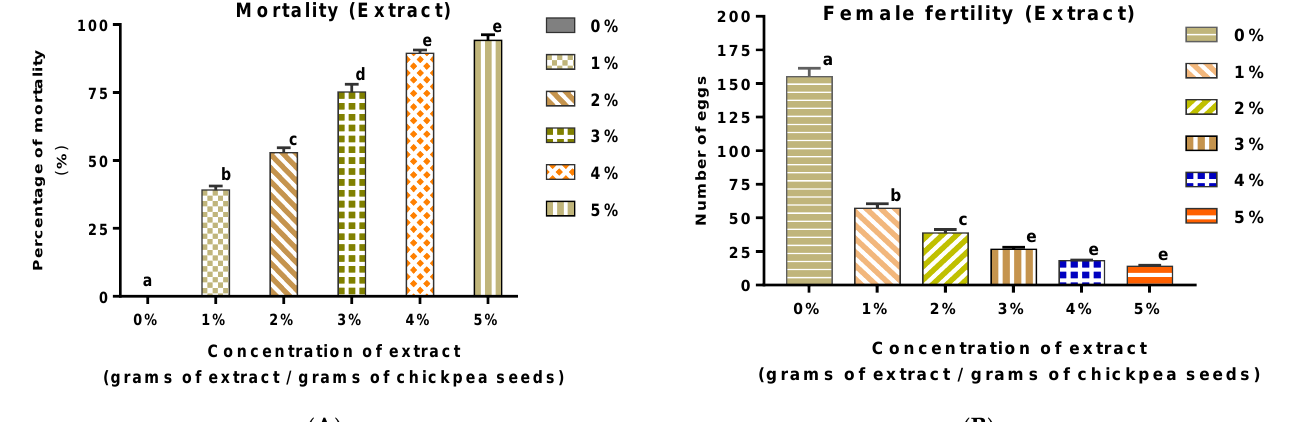
Figure 4. Effect of Withania adpressa Coss. ex Batt extract on Callosobruchus maculatus. ( A ) Average mortality of adults treated with different doses of hydroethanol extract. ( B ) Fecundity of females after treatment with various doses of hydroethanol extract. Column values with the same letters are not significantly different ( n = 3, ANOVA, Tukey ’ s HSD, p -value less than 0.05 considered to be significant).